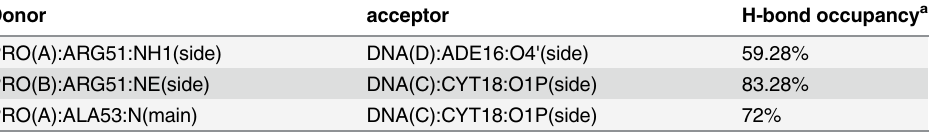
Table 1. H-bonds between the hinge region and DNA.